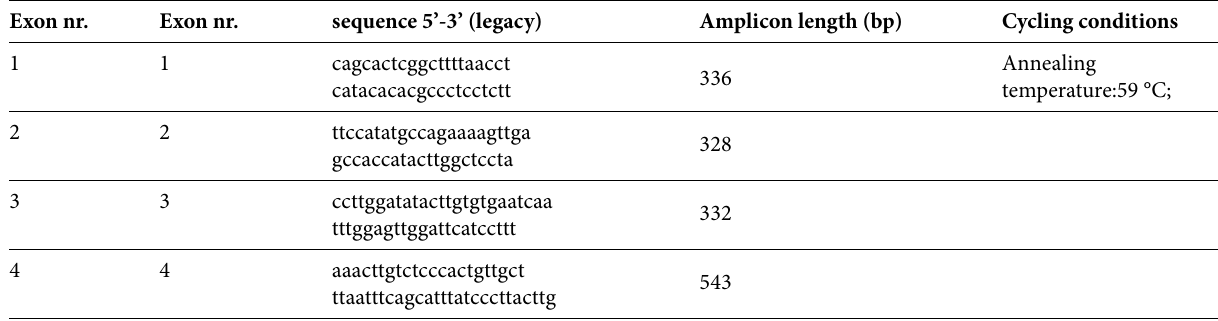
Table 1. Primers used for the sequencing of the CFTR gene coding region and cDNA. Exon nr. Exon